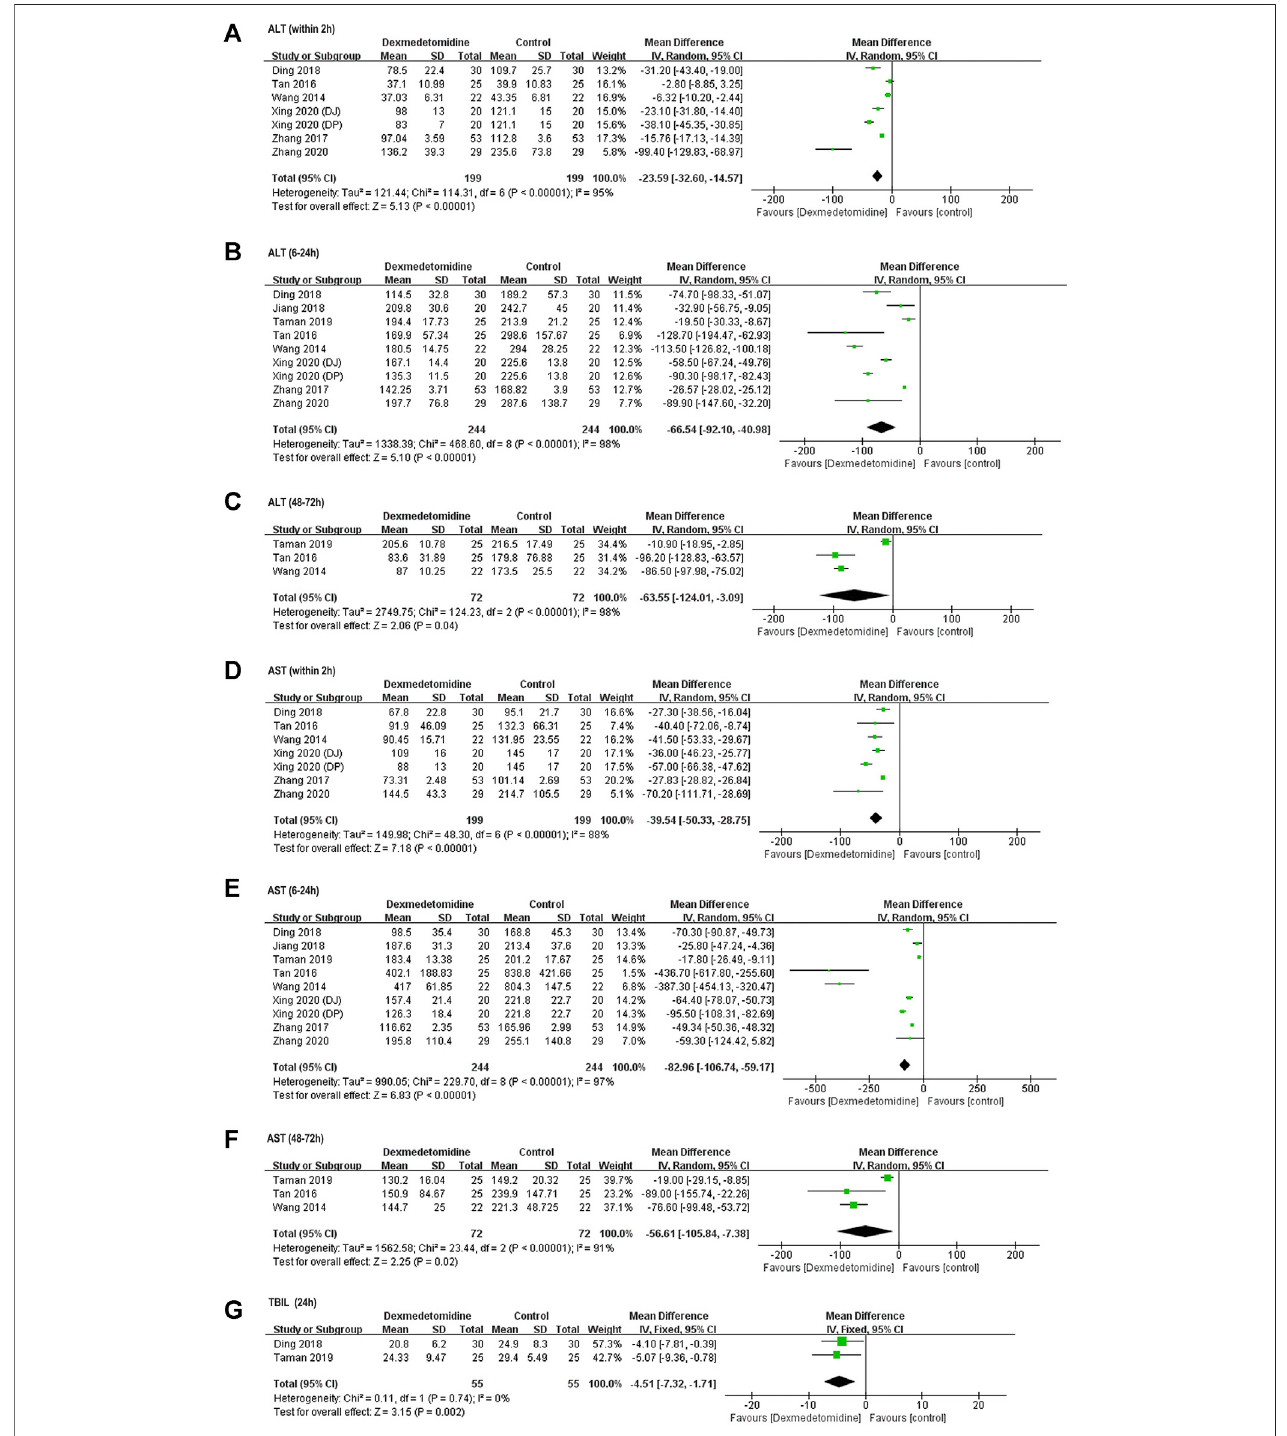
FIGURE 2 | Forest plots for meta-analyses comparing postoperative liver function between dexmedetomidine and control group of participants undergoing hepatectomy. (A) ALT (within 2 h after surgery); (B) ALT (6 – 24 h after surgery); (C) ALT (48 – 72 h after surgery); (D) AST (with 2 h after surgery); (E) AST (6 – 24 h after surgery); (F) AST (48 – 72 h after surgery); (G) TBIL (24 h after surgery).